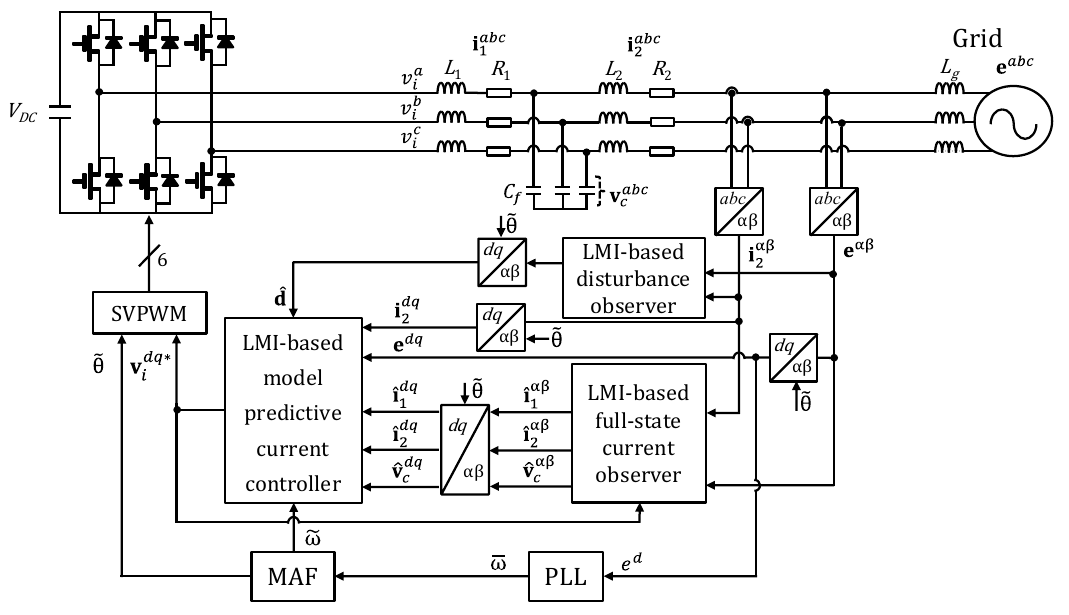
Figure 1. Configuration of three-phase GCI with LCL filter and the proposed control